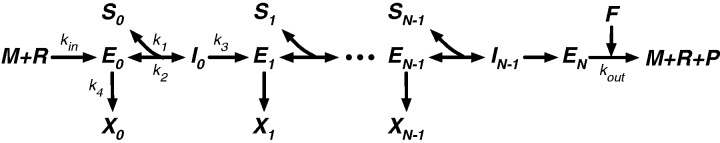
Model of translation as an enzymatic process. The translation of a full protein is modeled by a series of enzymatic reactions, each as shown in figure 1. Free ribosome R binds to mRNA M and initiates translation. At each step i, the required aa-tRNA Si is added to the ribosome–mRNA–peptide complex Ei that already has a peptide chain of length i. The final complex EN is released by release factor F to create free ribosome R, mRNA M, and protein P. kin, rate of translational initiation; kout, rate of protein release. Ii, Xi, and k1–k4 are described in figure 1.